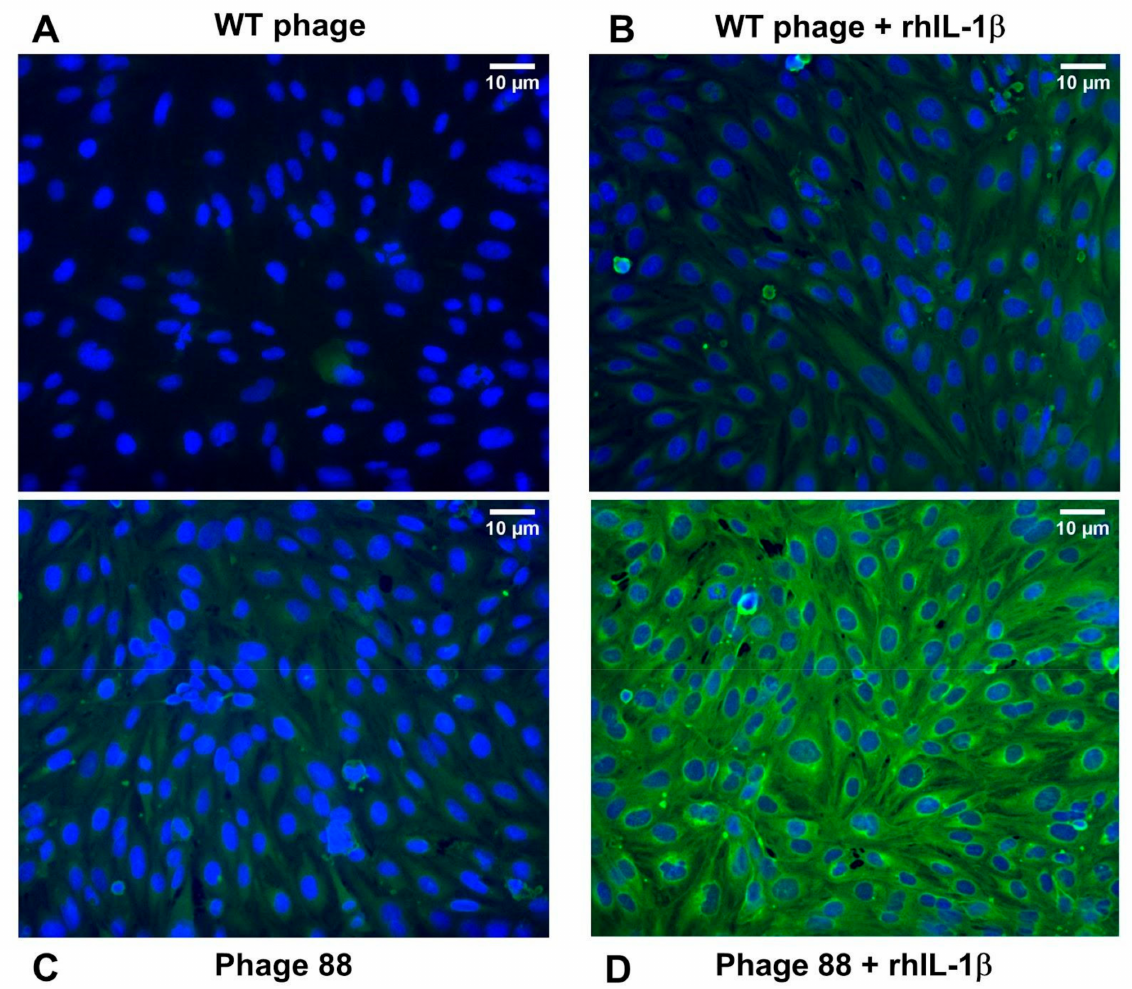
Figure 1. Crosslinking of phage 88 and target proteins on hCMEC/D3 cells. Sulfo-SBED labeled phage 88 or WT were crosslinked with protein targets on the hCMEC/D3 cells under rhIL1- β simulating proinflammatory conditions or in a resting state. ( A ) cells without stimulus of rhIL-1 β incubated with WT phage; ( B ) cells stimulated with rhIL-1 β and incubated with WT phage; ( C ) cells without stimulus of rhIL-1 β and incubated with phage clone 88; and ( D ) cells stimulated with rhIL-1 β and incubated with phage-peptide-88. The crosslinking is detected by labeling of Sulfo-SBED with streptavidin- DyLight 488 (green). Nuclei stained with DAPI are shown in blue. Phage photographs are representative images from two independent experiments (10 × ). Bar = 10 µ